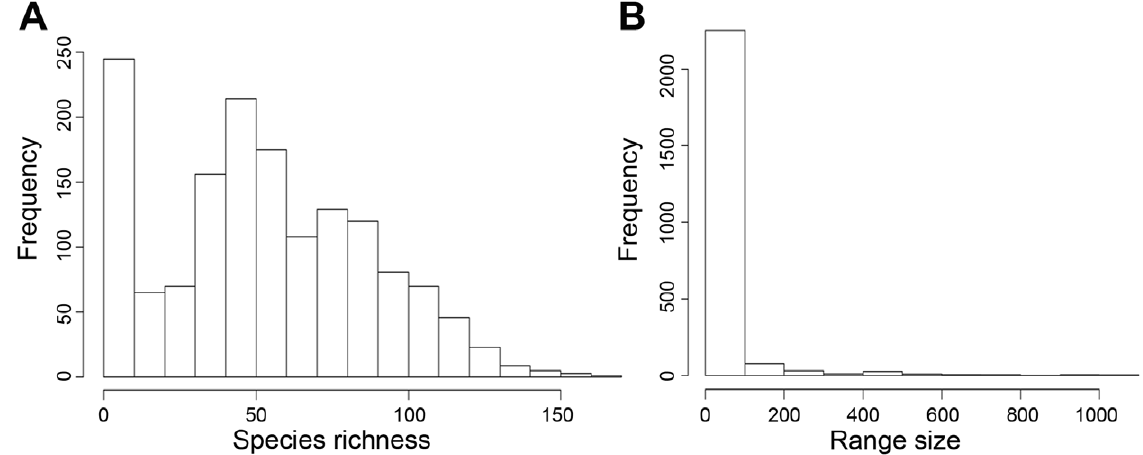
Figure 2. Histograms of (A) species richness and (B) range size frequency distributions.